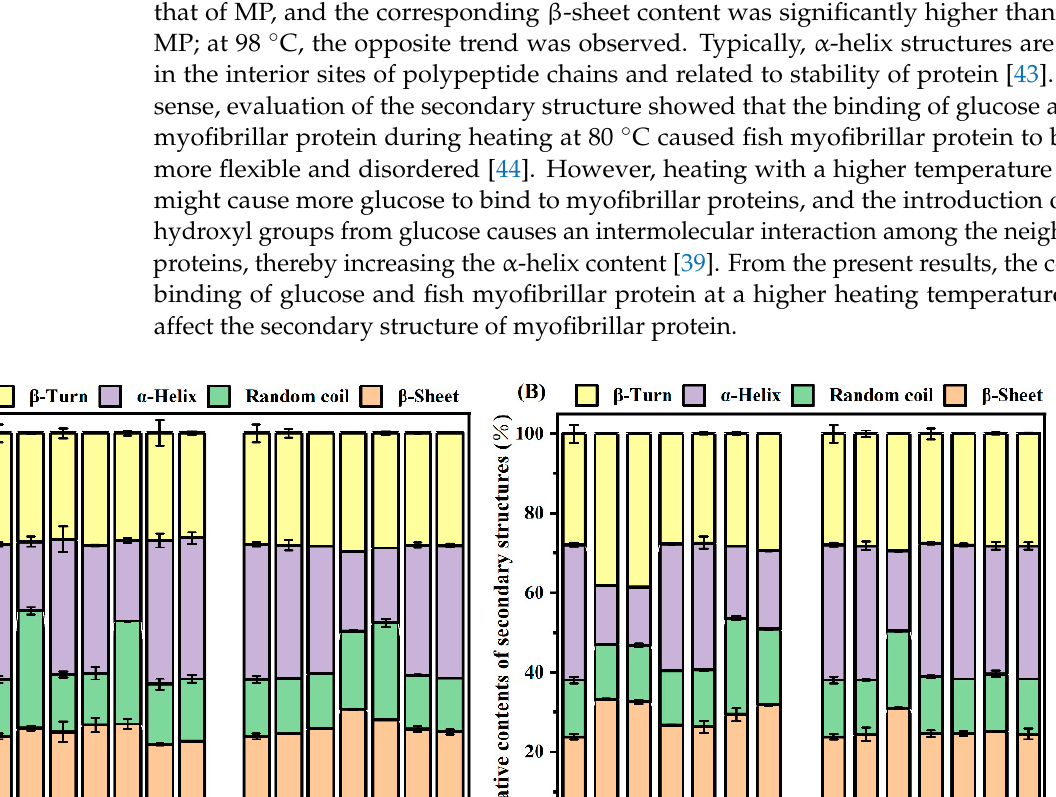
Figure 6. Changes in Fourier transform infrared spectroscopy of myofibrillar protein and glucose (MPG) and myofibrillar protein (MP) heated at 80 °C ( A ) and 98 °C ( B ) for 0 − 45 min. Further information about secondary structure contents of MP and MPG under